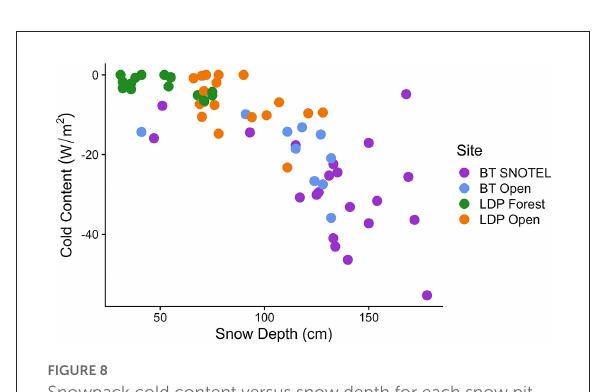
FIGURE8 Snowpack cold content versus snow depth for each snow pit and site for WY2020 and WY2021. There were two snow pits at each location (BT and